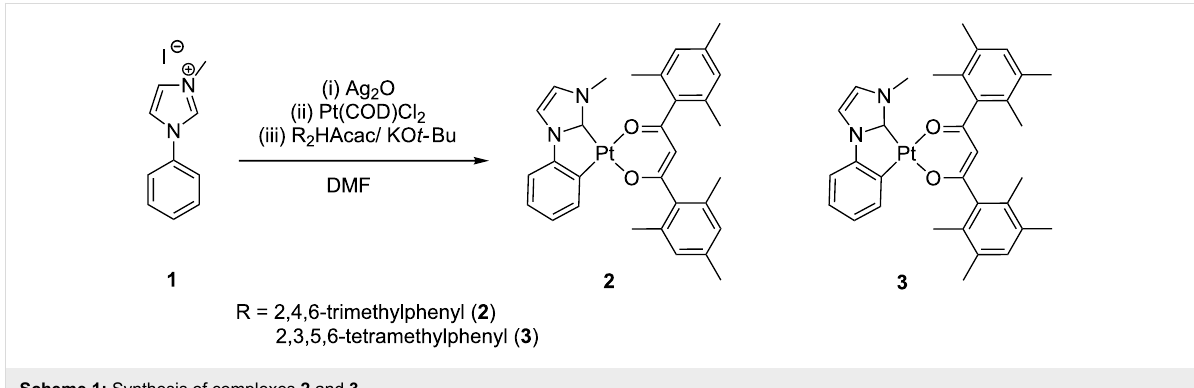
Scheme 1: Synthesis of complexes 2 and 3 .